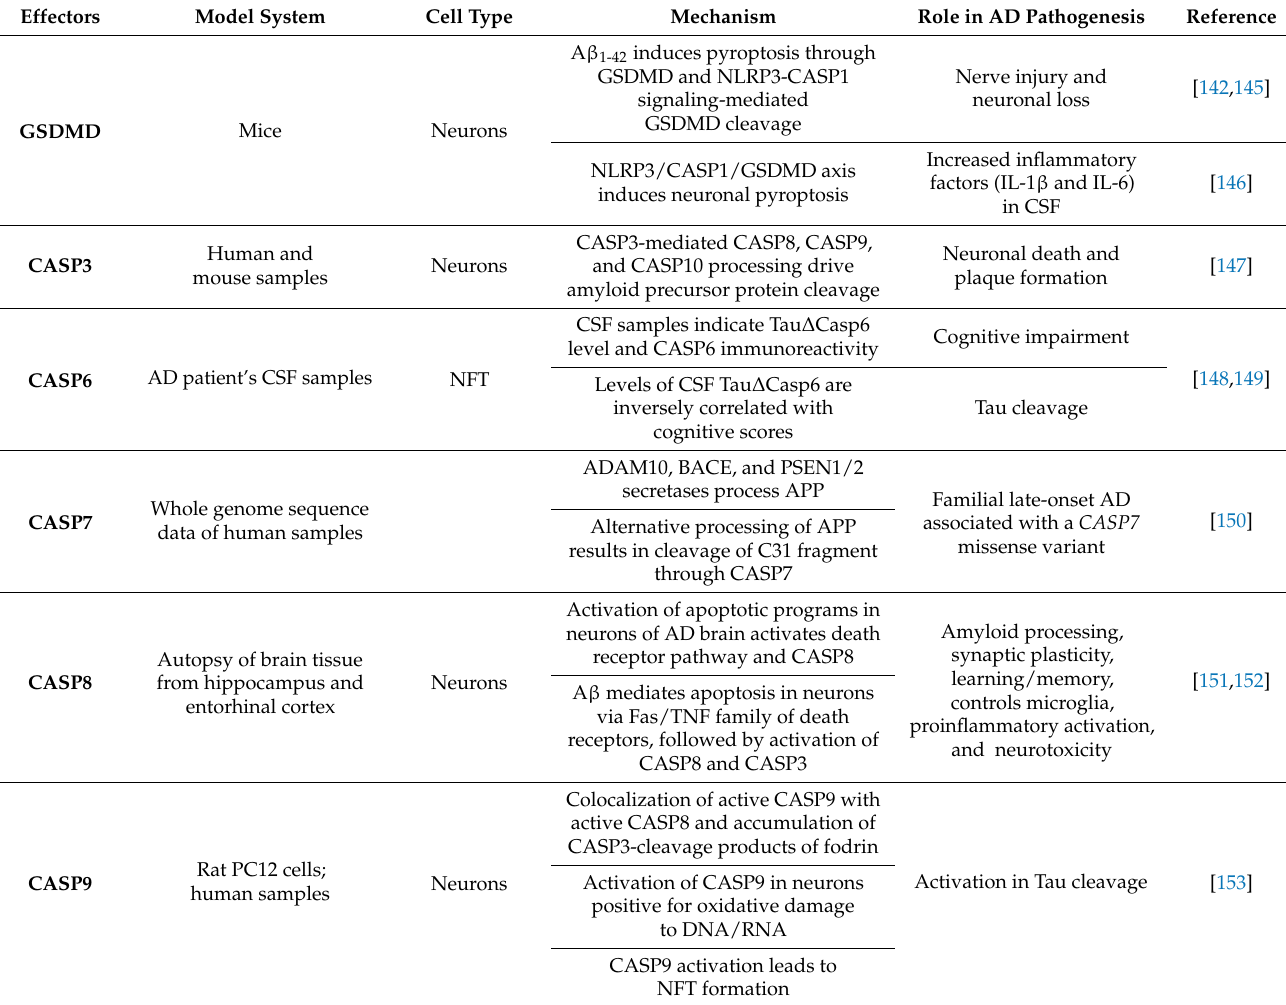
Table 3. Cell death effector molecules involved in Alzheimer’s